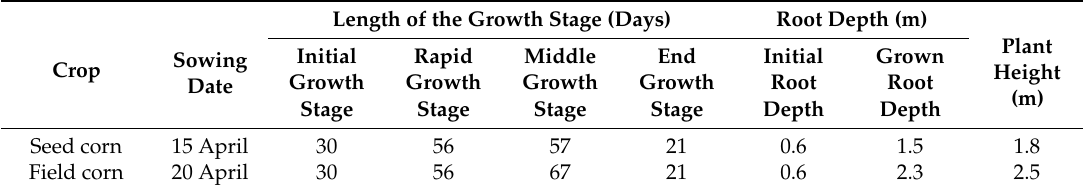
Table 1. Crop parameters of seed corn and field corn.